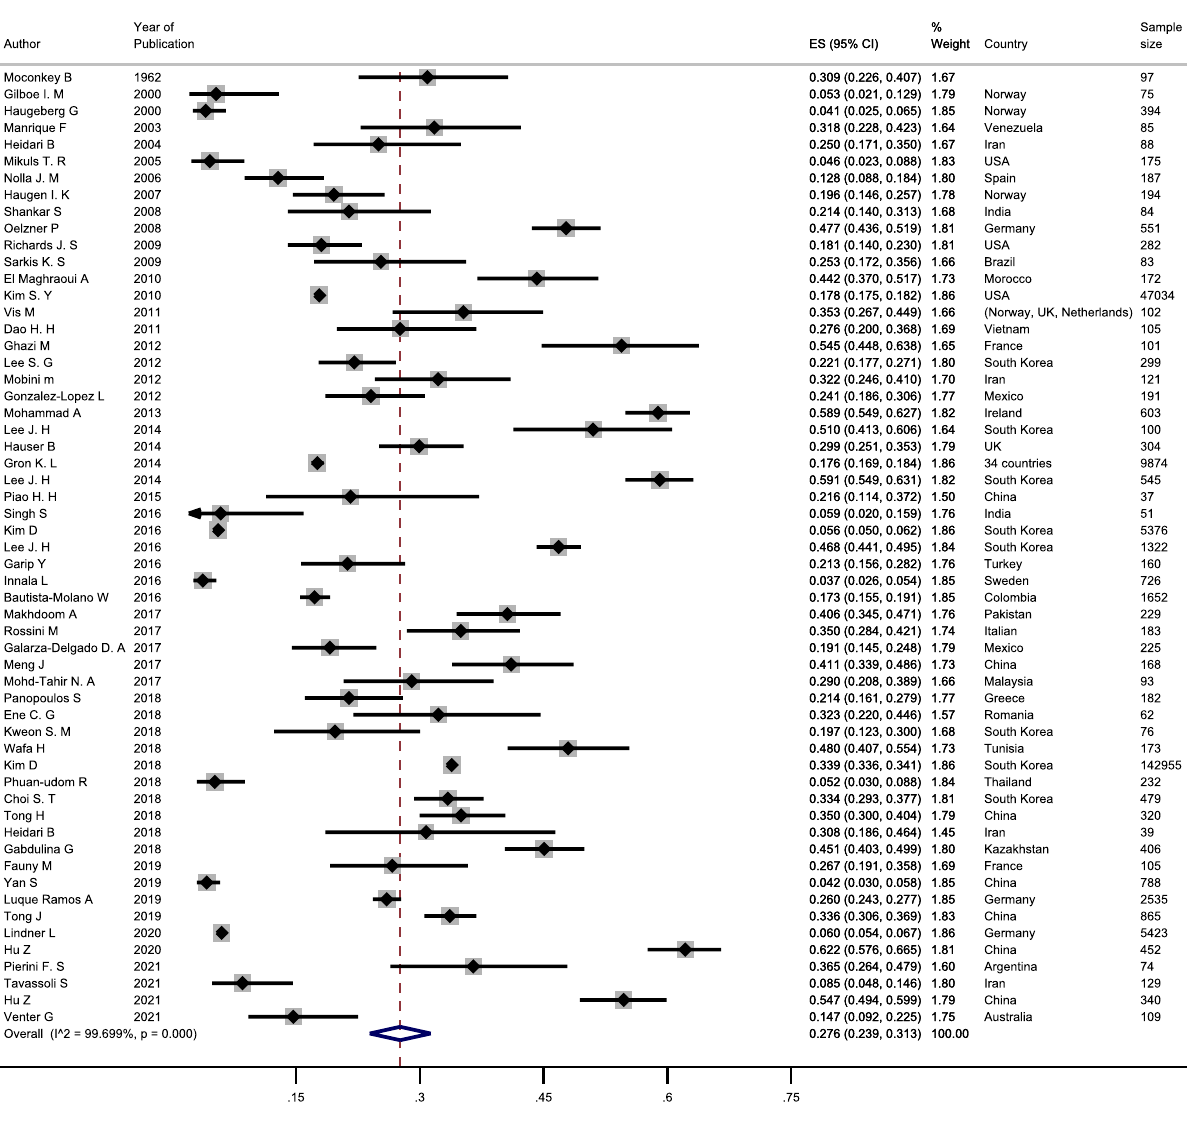
Figure 2. Forest plot showing the prevalence of osteoporosis among rheumatoid arthritis patient.